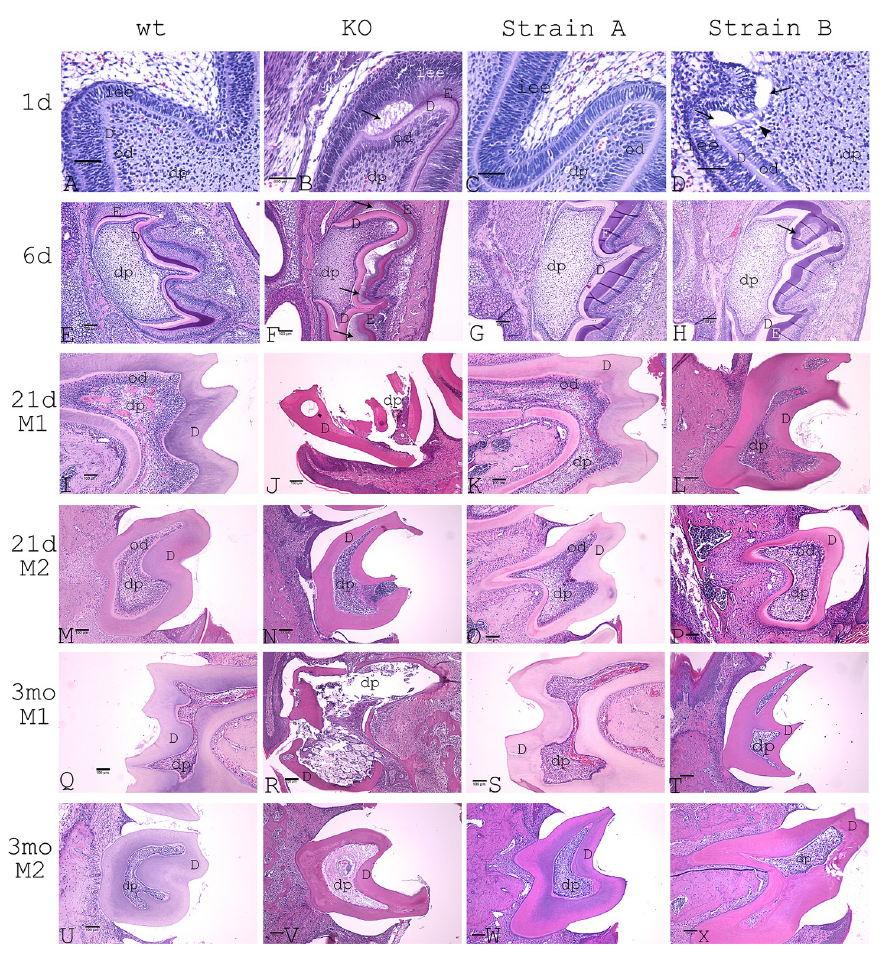
Fig 4. H&E staining of mouse molars at various postnatal time points. A-D: postnatal 1-day molar 1 (M1) at 400x magnification, bar for 50 μ m. A: wt. B: DSPP KO. C: Strain A. D: Strain B. Arrows represent the appearance of abnormal dental pulp cells. E-H: postnatal 6-day M1. E: wt. F: DSPP KO. G: Strain A. H: Strain B. dp represents dental pulp. od represents odontoblast layer. D represents dentin. E represents Enamel. iee represents inner enamel epithelium. I-L: postnatal 21-day M1. I: wt. J: DSPP KO mouse. K: Strain A. L: Strain B. M-P: postnatal 21-day M2. M: wt. N: DSPP KO. O: Strain A. P: Strain B. Q-T: postnatal 3-month M1. Q: wt. R: DSPP KO. S: Strain A. T: Strain B. U-X represent postnatal 3-month M2. U: wt. V: DSPP KO. W: Strain A. X: Strain B. E-X: 100x magnification, bar for 100 μ m.dp represents dental pulp. D represents